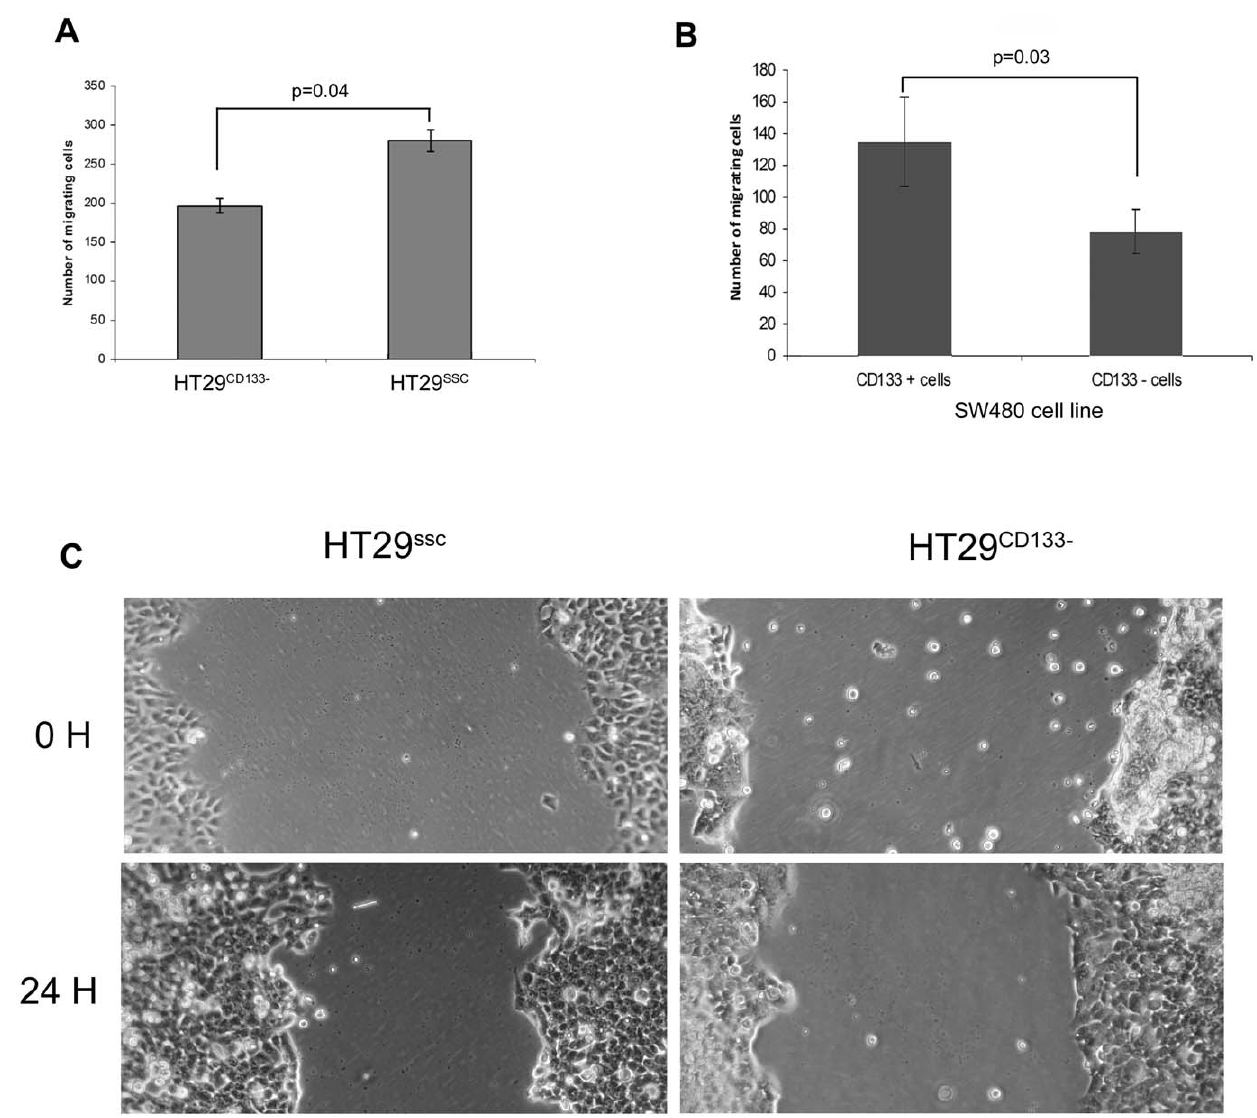
Figure 6. Effect of CD133 on cell motility. Transwell migration was measured after knockdown of CD133 in HT29 and sorting of SW480 into CD133 + / 2 populations. Significantly fewer HT29 CD133 2 cells migrated across the membrane than HT29 ssc cells (Figure 6a, p=0.04). Conversely, larger numbers of sorted CD133 + cells migrated than CD133 2 cells (Figure 6b, p=0.03). A wounding assay was also undertaken and gene knockdown was associated with marked delay in closure of the wound which was visiually perceptible after only 24 hours (Figure 6c) and statistically significant (p , 0.001).